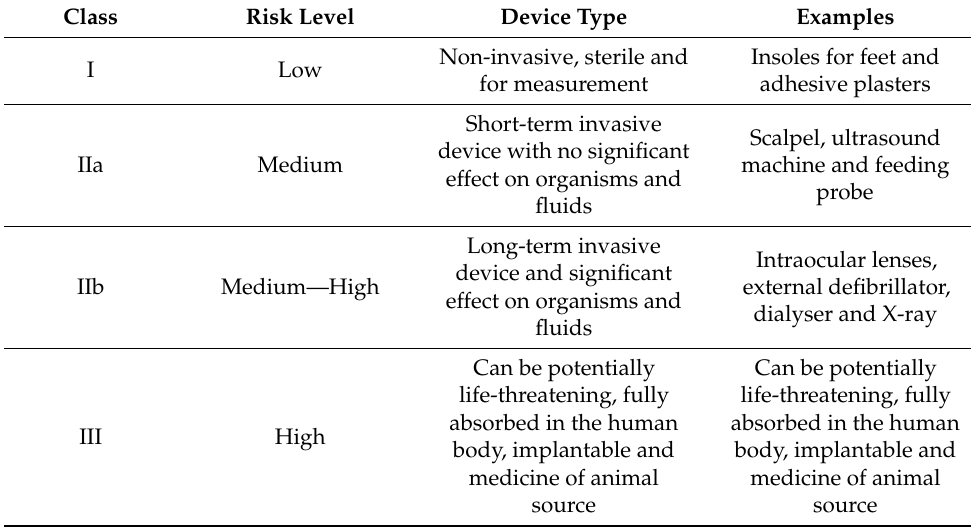
Table 1. Medical Device classification according to